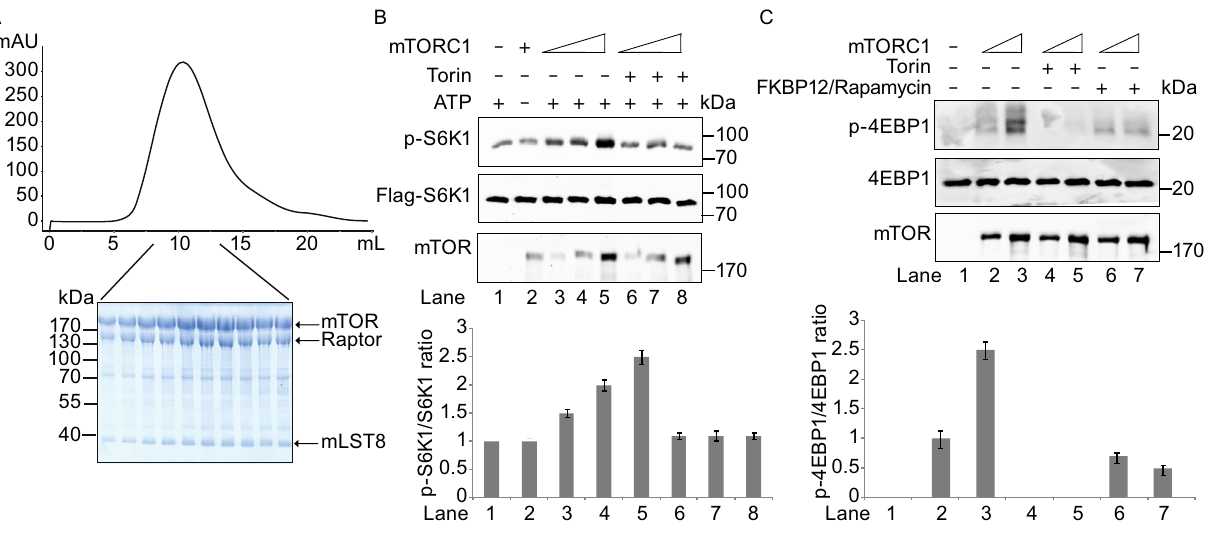
Figure 1. Size exclusion chromatogram of the human mTORC1 and kinase activity. (A) The gel- fi ltration was performed using a Superose 6 column (10/3004 GL, GE Healthcare). The peak fractions were subjected to SDS-PAGE and stained with Coomassie blue. (B and C) Phosphorylation of puri fi ed S6K1 (K100R) (B) and 4EBP1 (C) by mTORC1 in the presence or absence of Torin. The phosphorylation was detected by immunoblotting with antibodies targeting phospho-Thr-389 (top), Flag (middle), and mTOR (bottom) in (B), and antibodies targeting phospho-4EBP1 (top), 4EBP1 (middle), and mTOR (bottom) in (C). Below are the quanti fi cation of the immunoblots for B and